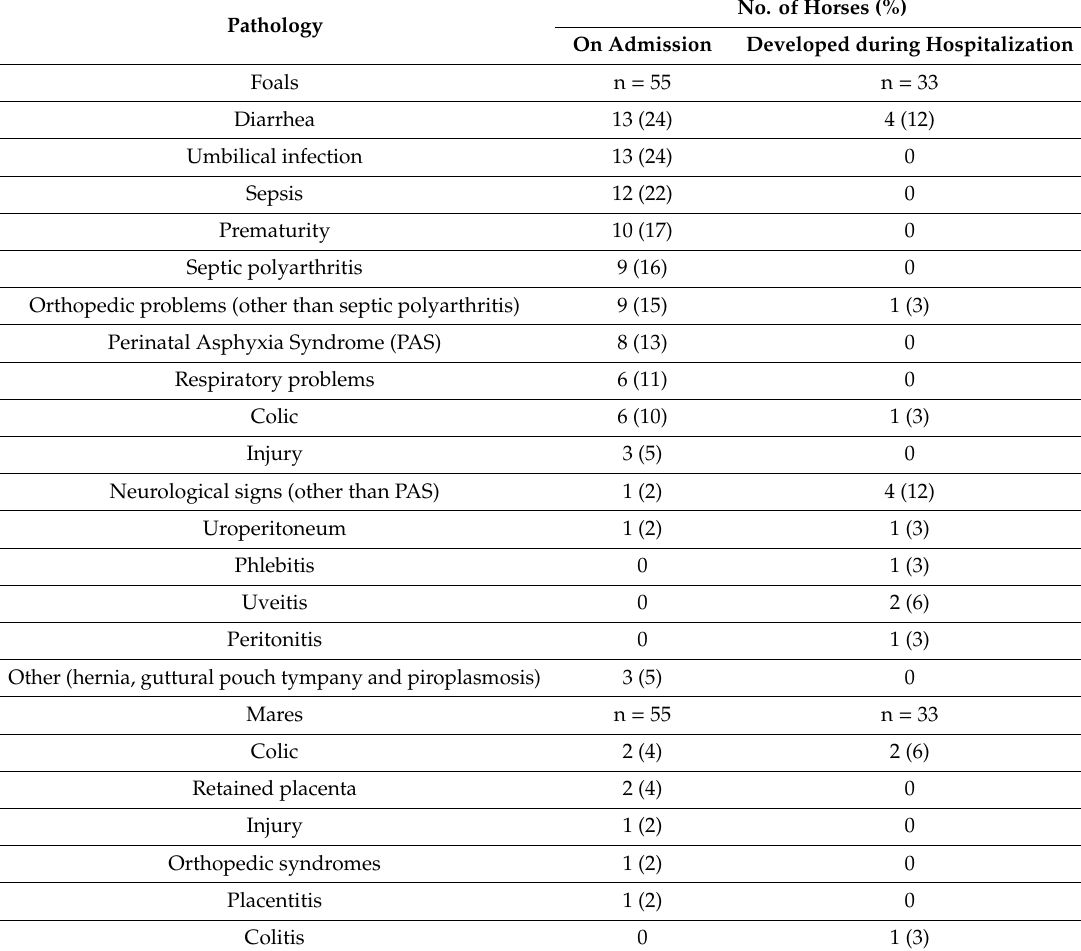
Table 1. Pathologies of foals and mares on admission and during